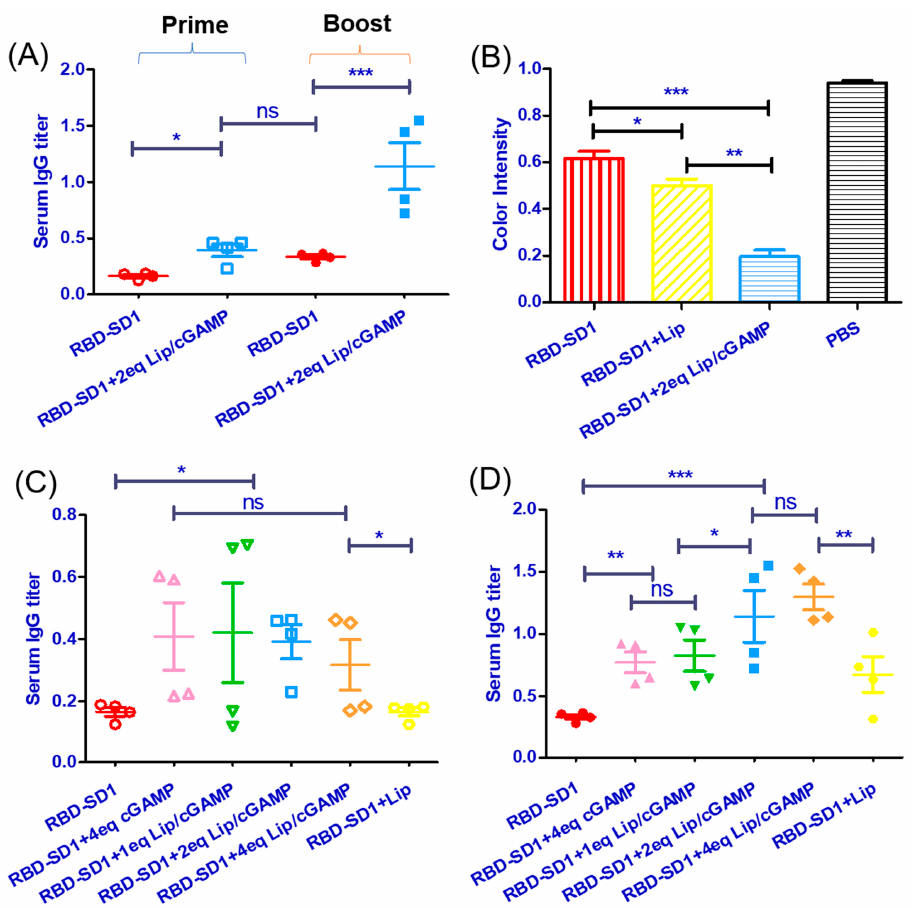
Figure 5. ( A ) Sera were collected on day 14 (Prime) or 21 (Boost) and measured for Ag-specific IgG. ( B ) Neutralizing antibody levels were determined with the 2019-nCoV Surrogate Virus Neutralization kit. Color intensity was inversely proportional to the RBD neutralizing antibody levels. ( C ) At day 14, the serum IgG titers were measured. ( D ) At day 21, the serum IgG titers were measured. n = 4 mice. Statistical analysis, one-way ANOVA * p < 0.05, ** p < 0.01, and *** p < 0.001, ns: no significance. All experiments were repeated twice with similar results. Each symbol represents individual mice. Red ○/● : group RBD-SD1 in Prime/Boost phase; pink △/▲ : group RBD-SD1+ 4eq cGAMP in Prime/Boost phase; green ▽/▼ : group RBD-SD1+ 1eq Lip/cGAMP in Prime/Boost phase; blue □/■ : group RBD-SD1+ 2eq Lip/cGAMP in Prime/Boost phase; orange ◇/◆ : group RBD-SD1+ 4eq Lip/cGAMP in Prime/Boost phase; yellow ⎔/⬣ : group RBD-SD1+ Lip in Prime/Boost phase.